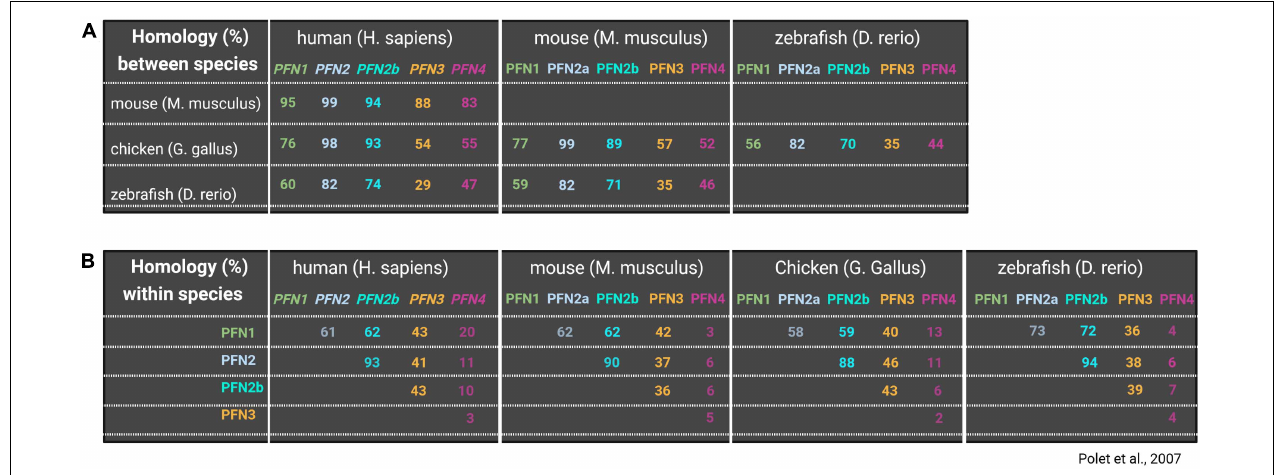
FIGURE 1 | Comparison of profilin isoform amino acid sequences between and within organisms. Upper panel (A) shows homologies (%) of all profilins between different species including human, mouse, chicken and zebrafish. Lower panel (B) shows homology (%) of different profilins within the same species (lower panel). Blank squares were left blank to avoid redundant information. Information on profilin homologies are based on Polet et al.